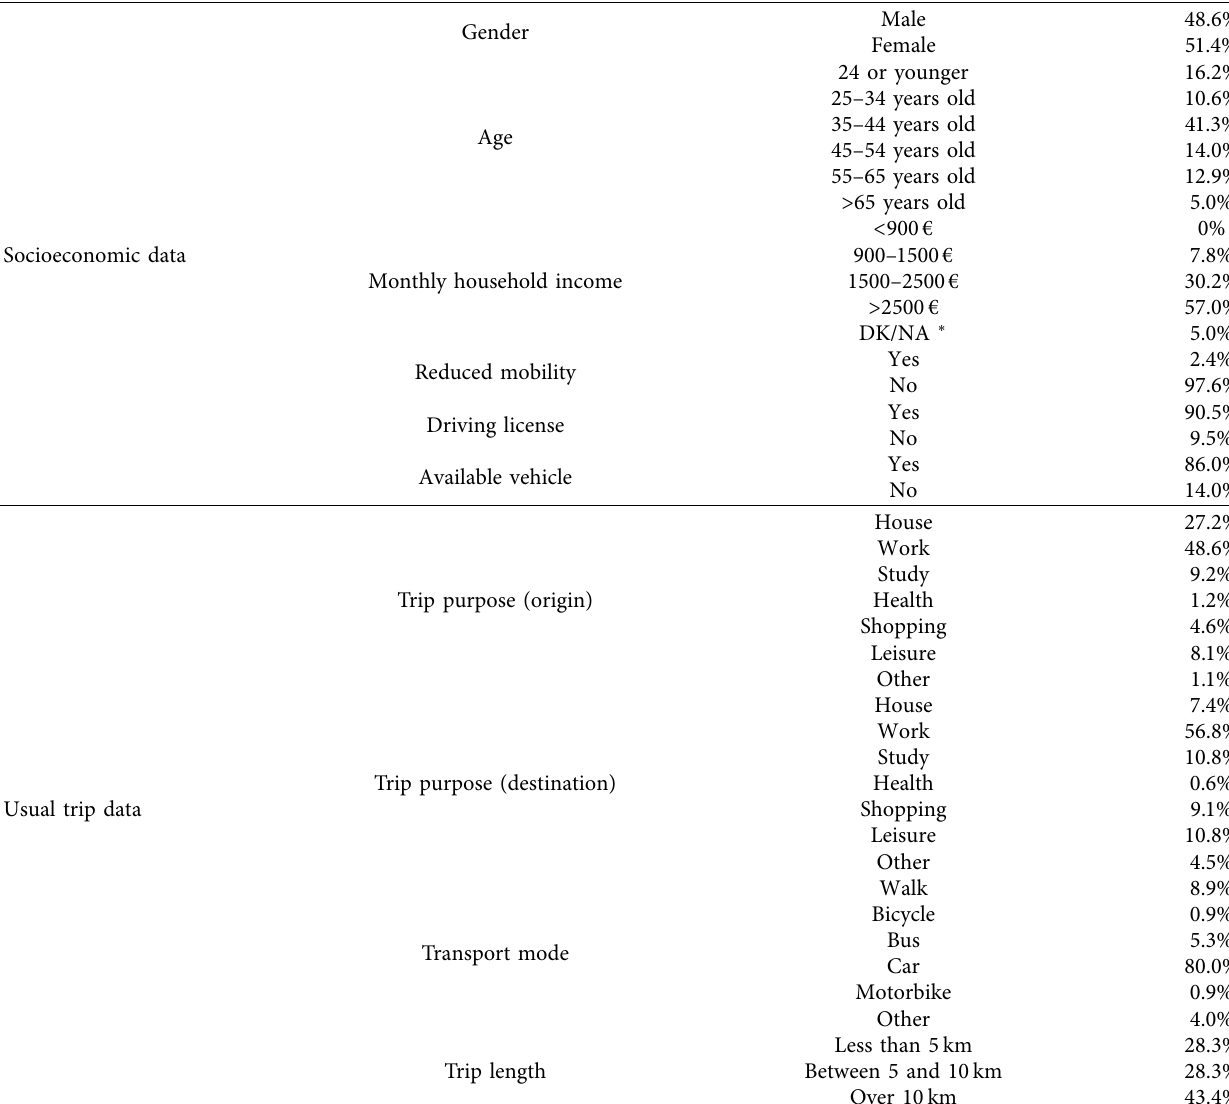
Table 4: Socioeconomic and usual trip characteristics of the respondents ( n �